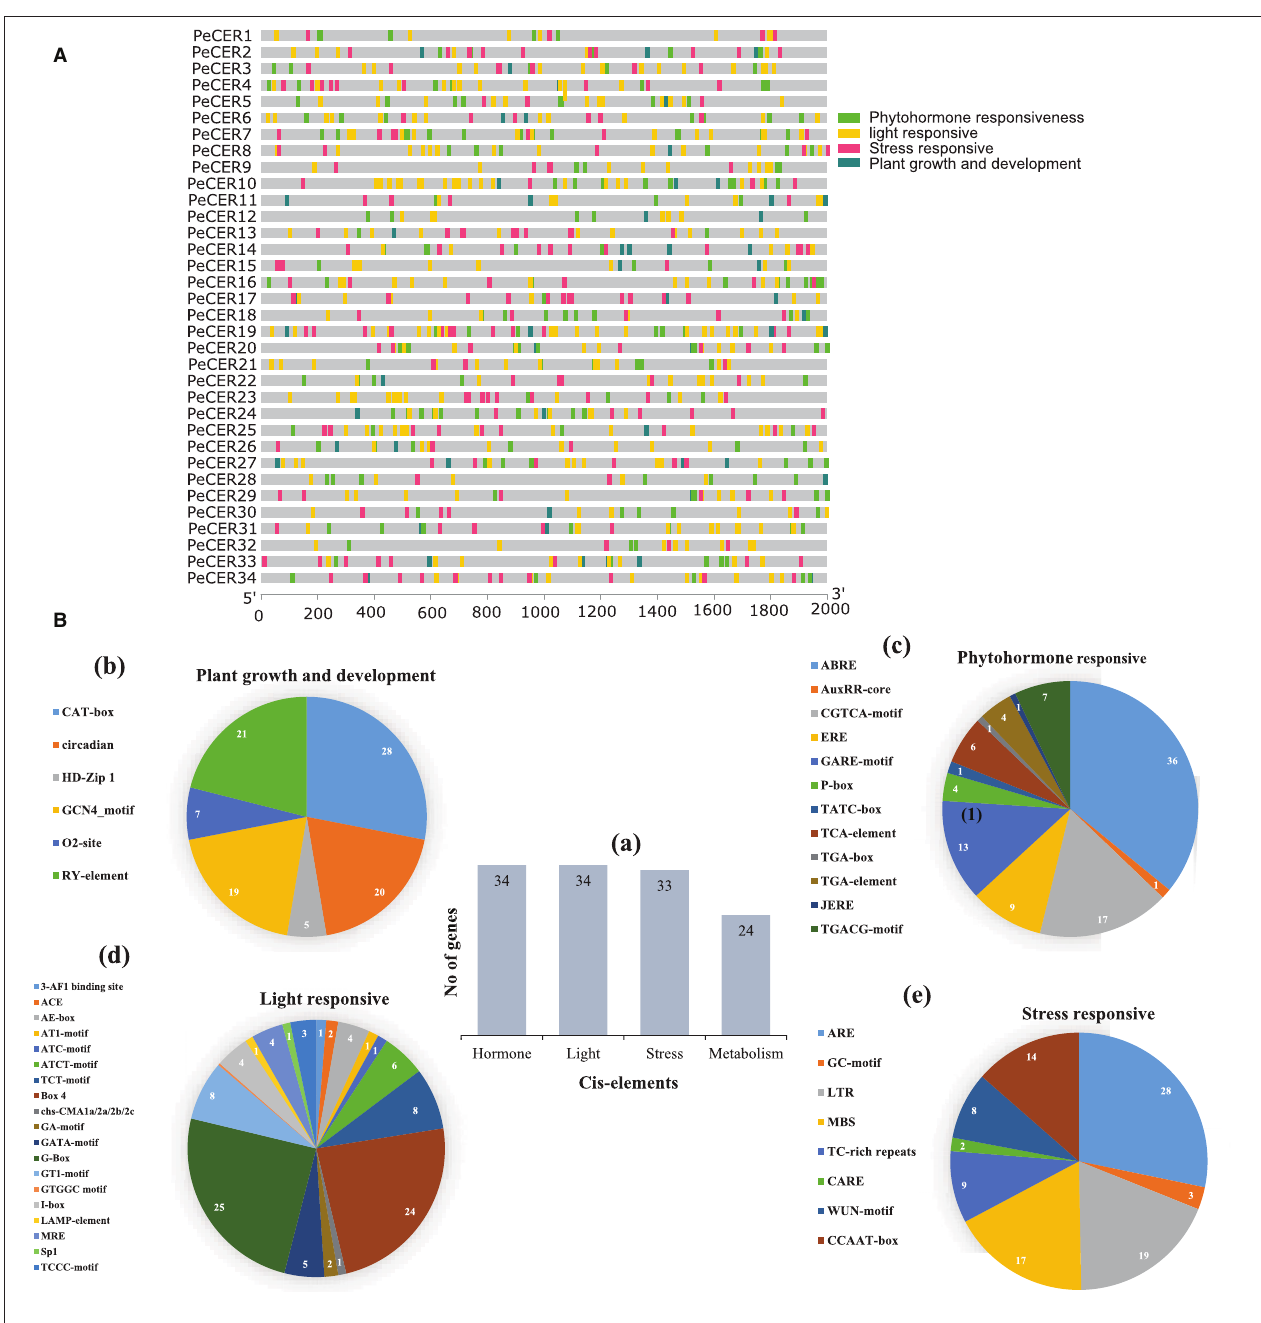
FIGURE 2 | (A) Cis-regulatory element analysis on PeCER genes. (B) (a) Sum number of cis-elements and PeCER genes involved in four categories. Percentage (%) ratio of numerous cis -elements from each category is presented in pie charts; (b) plant growth and development-responsive, (c) phytohormone-responsive, (d) light-responsive, (e) stress-responsive. Different colors indicate different cis-acting elements and their ratio present in PeCER